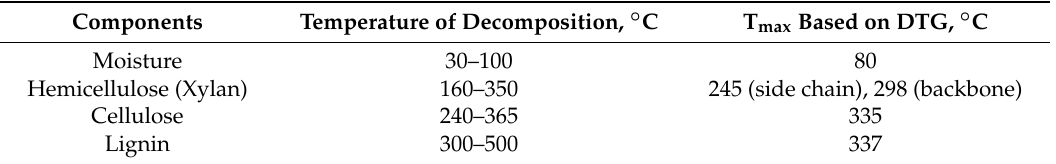
Table 5. Decomposition Temperature of Fiber Components [25,47]